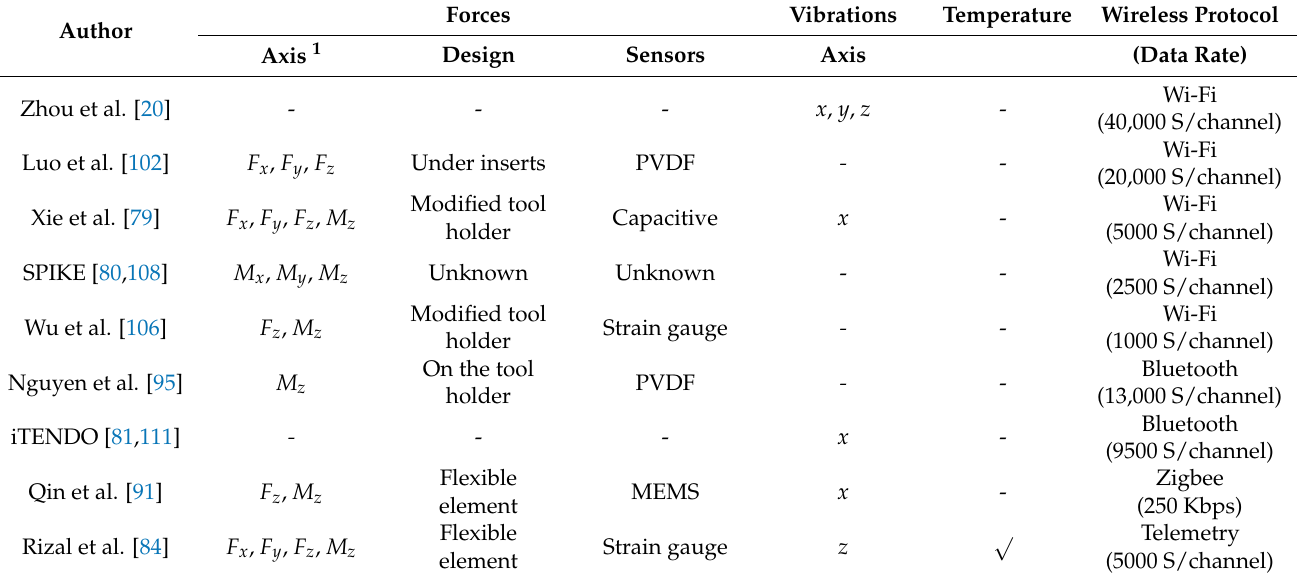
Table 1. Comparison of several wireless TCM tool-embedded sensor